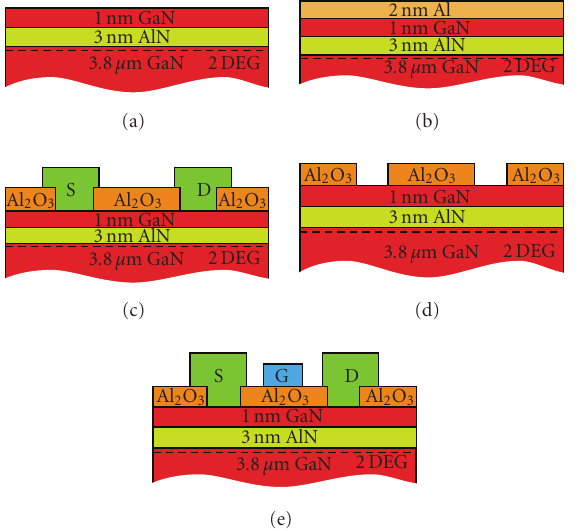
Figure 7: Process flow for fabrication of protected and passivated AlN/GaN MOS-HEMTs using the gate wrap-around technique. Processing includes (a) sample cleaning and deoxidation, (b) 2nm Al deposition, (c) etching Ohmic regions and thermal oxidation of Al, (d) Ohmic metallisation and annealing, and (e) gate metallisation and device measurements.